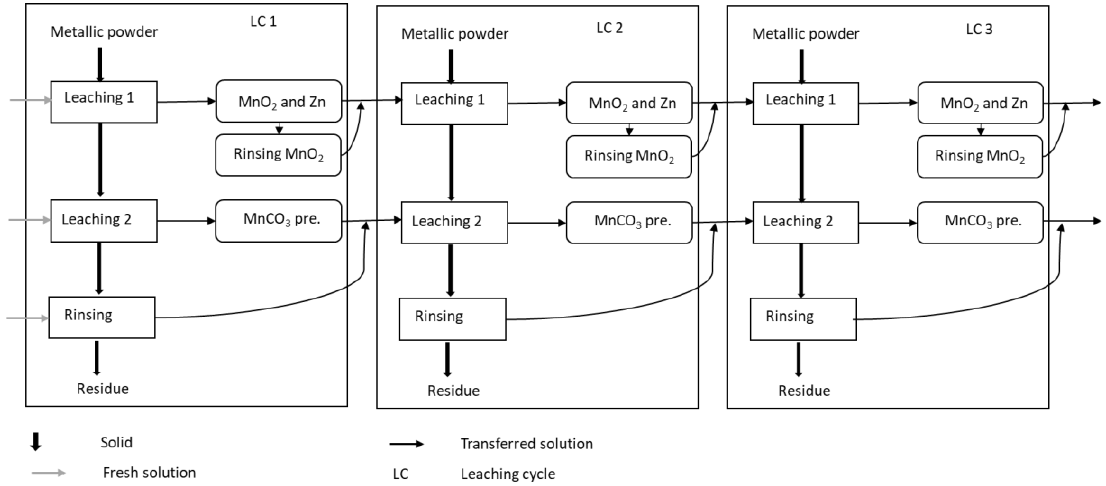
Figure 2. Schematic representation of the counter-current leaching and recovery process including rinsing steps performed on metallic powder.